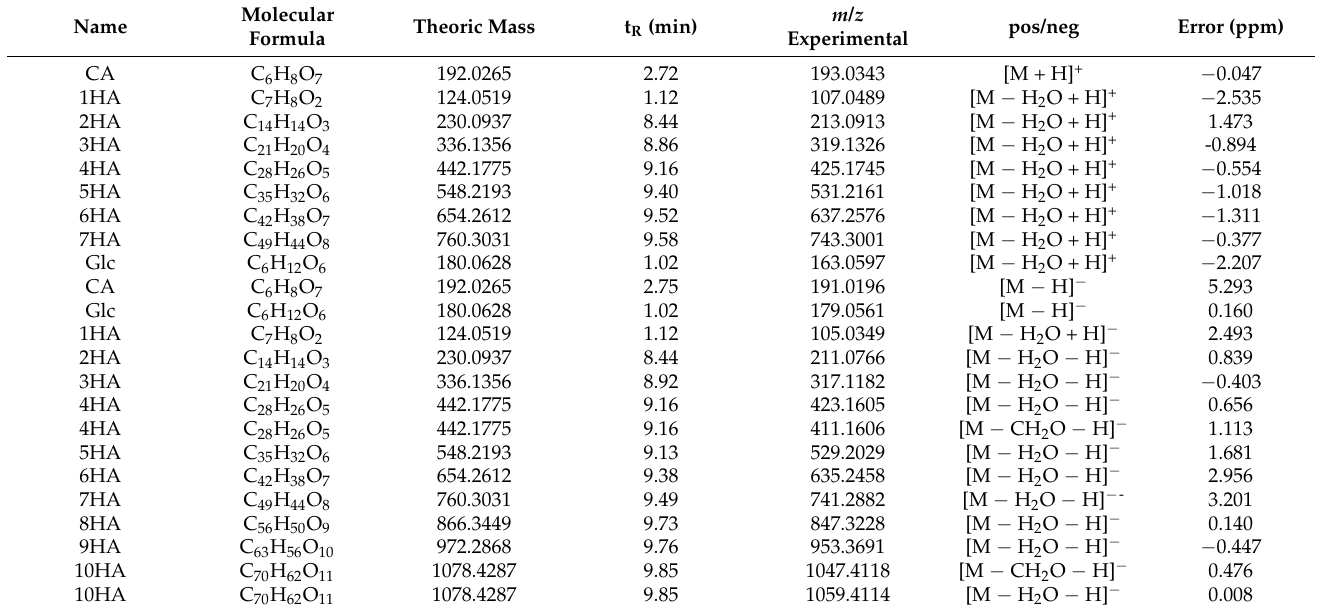
Table 2. LC-MS results of non-polysaccharide constituents in GEP-1